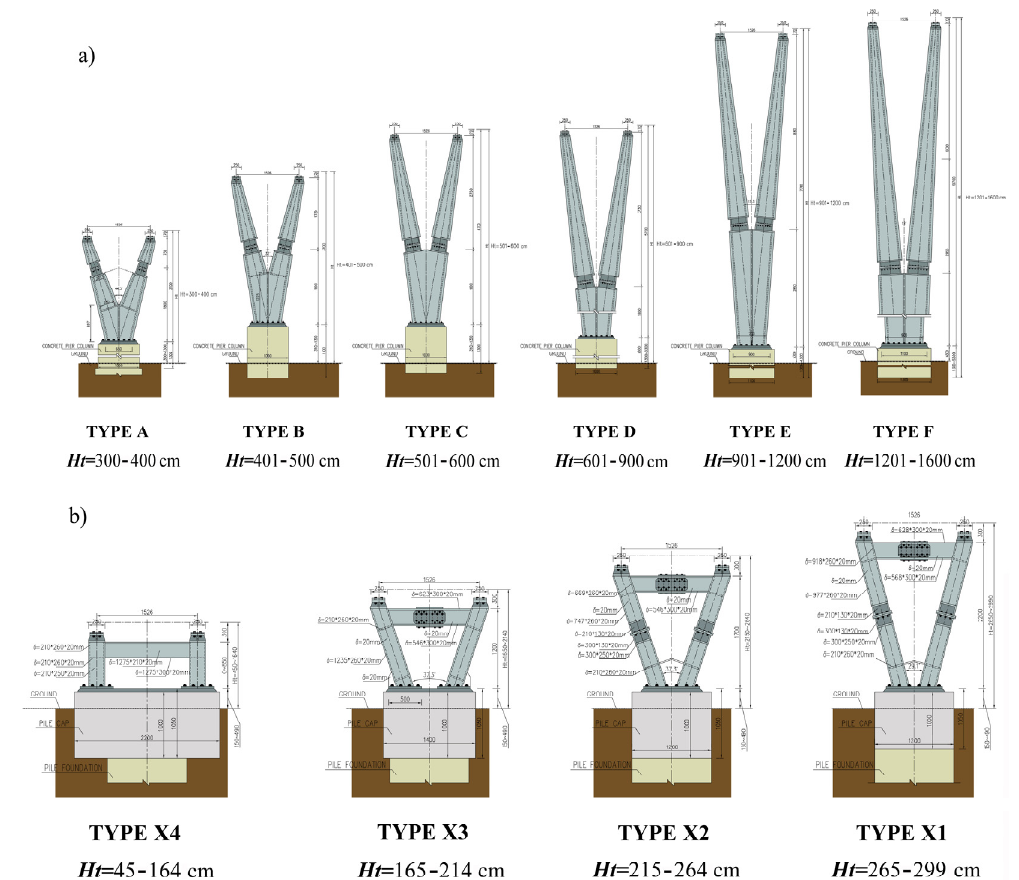
Figure 6. Various columns for the support structure of the Fu Forest trail: ( a ) the Y-shaped columns, with six types (Type A to F); ( b ) the steel structure columns, with four types (Type X1 to X4) (Source: author’s work).